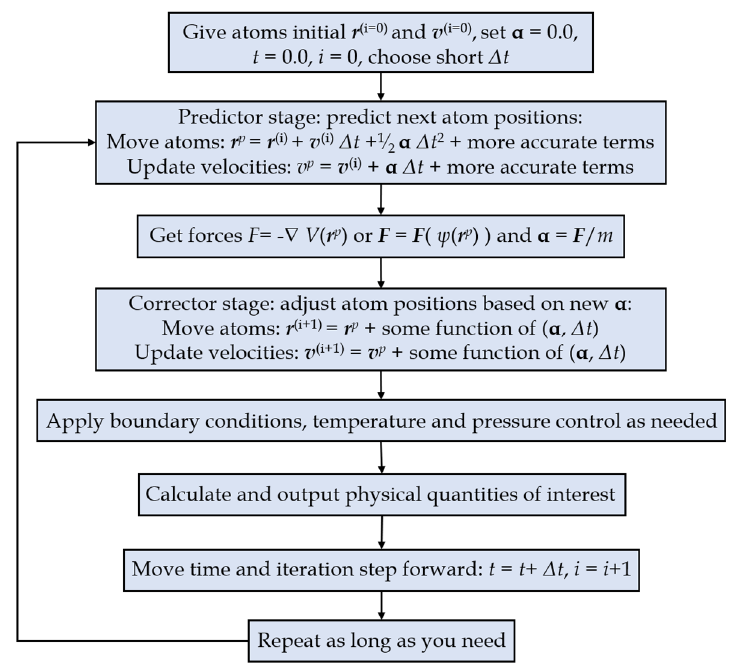
Figure 7. The flowchart of the MD method [46].